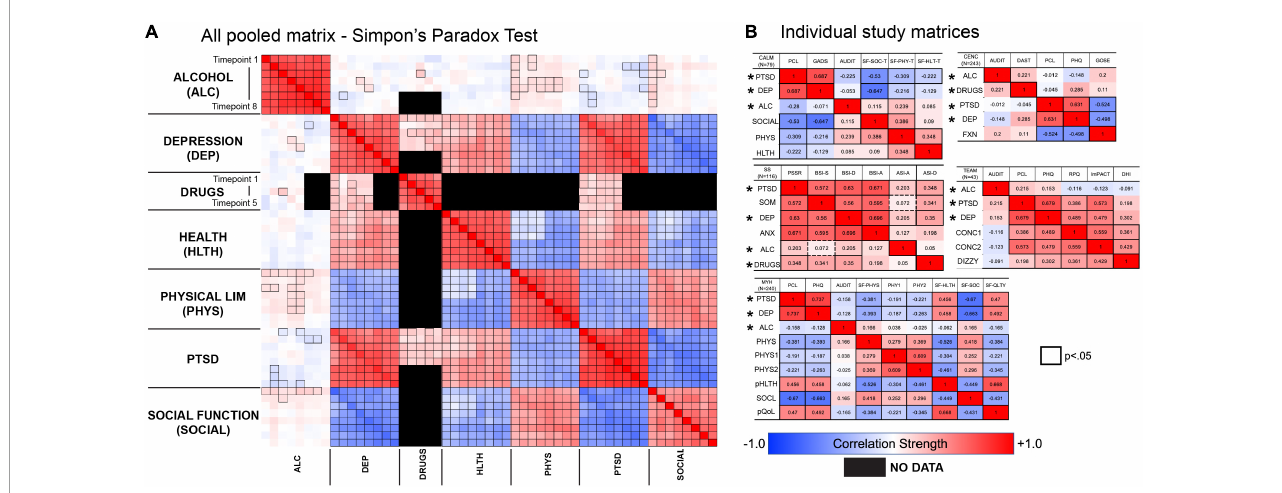
FIGURE7 Comparison of correlation matrix from pooled sample across all five studies (A) , compared to individual correlation matrices for each study (B) . Data across all five studies were combined to test whether different relationships would emerge with the pooled sample. We found that the patterns within each dataset were mostly conserved in the pooled dataset. *Indicates common outcomes across all